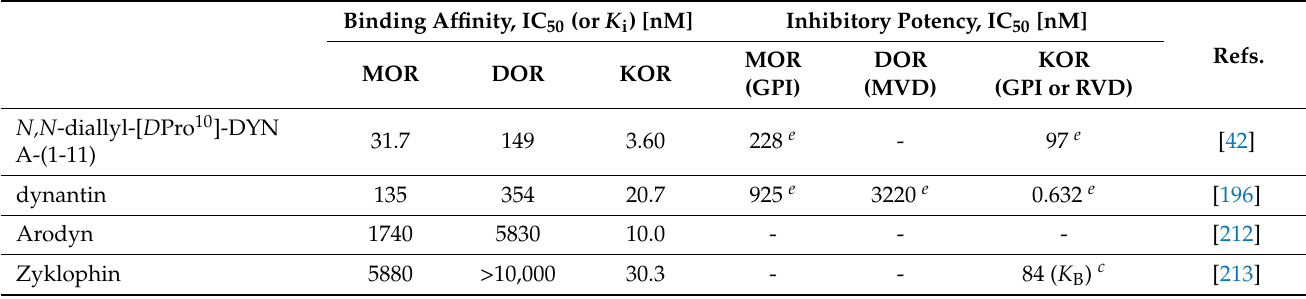
Table 2. Cont. Binding Affinity, IC 50 (or K i ) [nM] Inhibitory Potency, IC 50 [nM]